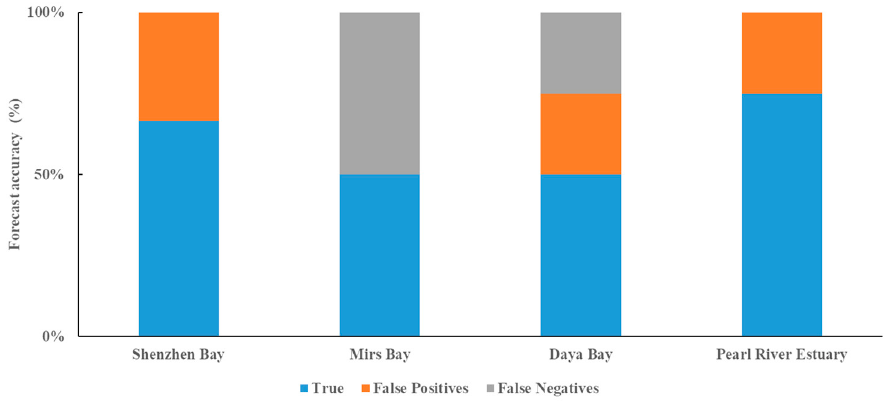
Figure 13. Forecast accuracy of HAB events in the four coastal areas of Shenzhen.